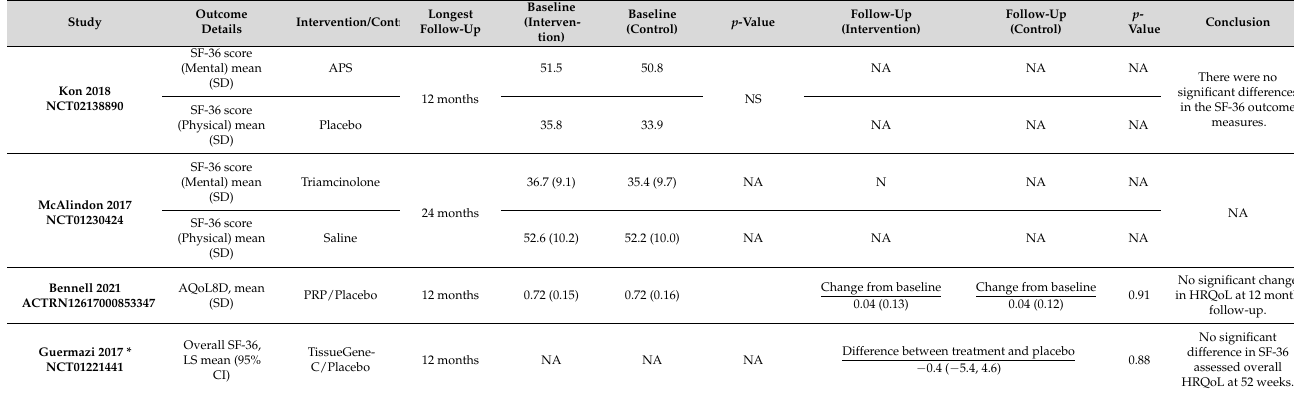
Table 4. Quality of life outcomes at longest reported follow-up.